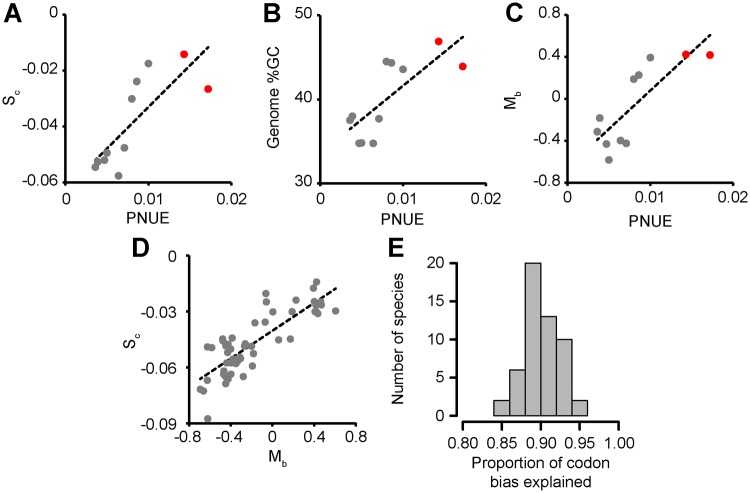
Photosynthetic nitrogen use efficiency (PNUE) modulates selection acting on transcript biosynthesis cost and mutation bias. Plots in parts A to C depict the same species set. C4 species are shown as red points and C3 species are shown as gray points. Complete data sets are provided in supplementary file S1, Supplementary Material online. (A) The relationship between PNUE and the strength of selection acting on transcript biosynthesis cost (Sc, R2 = 0.62) for these species. (B) The relationship between PNUE and the Genome wide GC content (R2 = 0.58). (C) The relationship between PNUE and mutation bias acting on coding sequences here values >0 indicate mutation bias toward GC and values <0 indicate a mutation bias toward AT (Mb, R2 = 0.65). (D) The relationship between Sc and Mb for all angiosperm species in Phytozome (R2 = 0.69). (E) The proportion of codon bias that can be explained by the joint effects of mutation bias and selection acting on nitrogen biosynthesis cost.